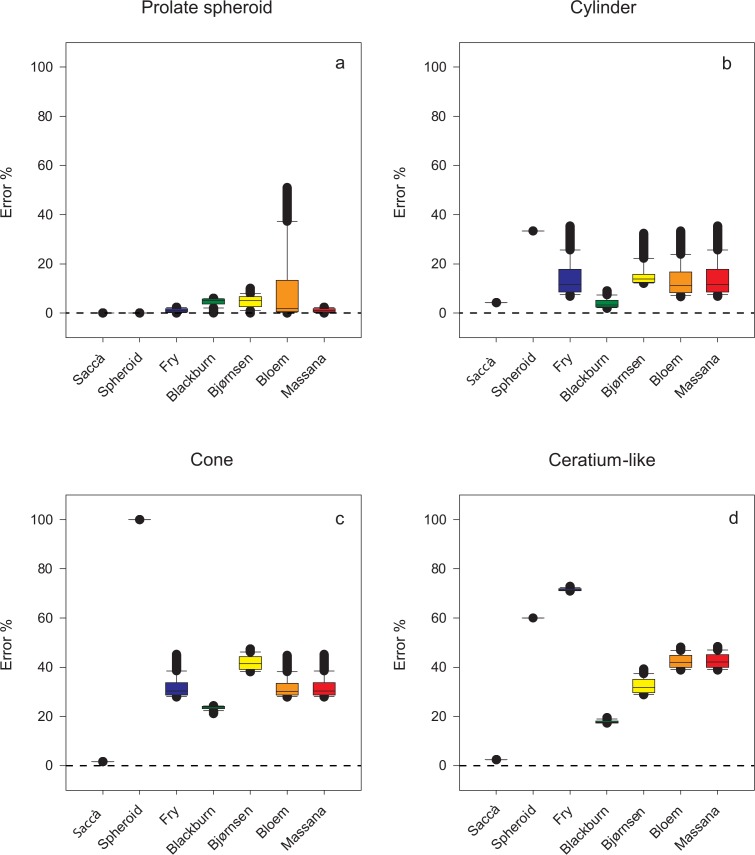
Box plots showing the errors caused by the new equation and the other tested methods in the estimation of the volume of four of the eight simple or composite geometric shapes (those yielding constant errors with the new equation and the prolate spheroid equation).The median, as well as the 10th, 25th, 75th, and 90th percentiles are shown. Whiskers indicate the 10th percentile and 90th percentile, respectively; while the extent of outlying points (solid circles) identifies the data range (standard method is used to calculate percentile values).